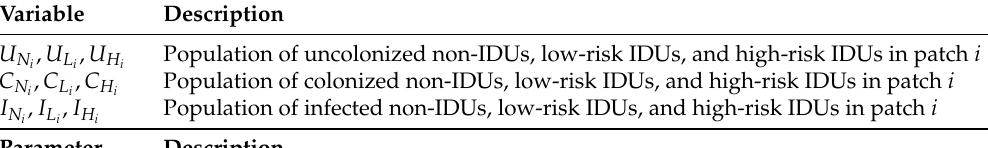
Table 1. Variable and Parameter descriptions for the MRSA model Equation (1) per